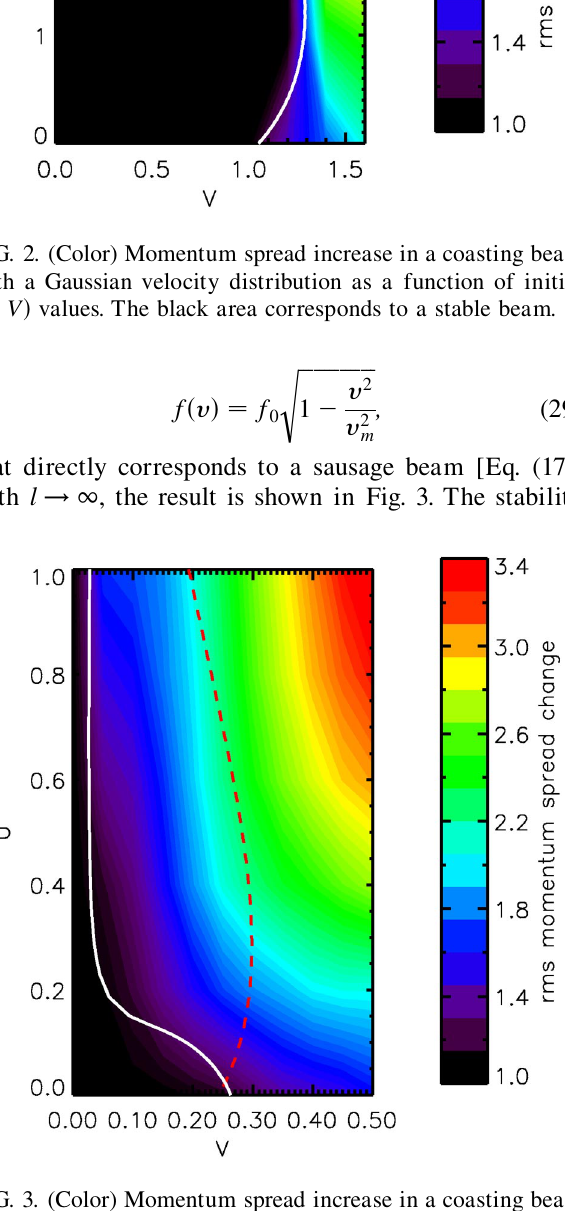
FIG. 4. (Color) Typical standing wave pattern on a sausage beam induced by a resonator impedance. The red dotted curve represents the unperturbed current profile.